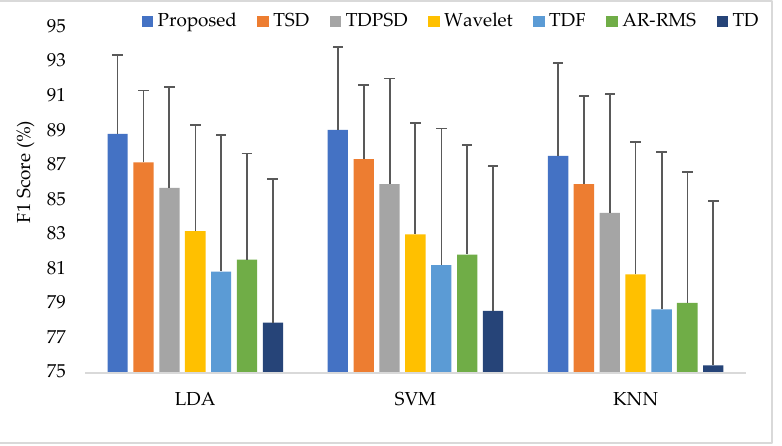
Figure 9. The average performances when the classifiers are trained and tested with three forces.